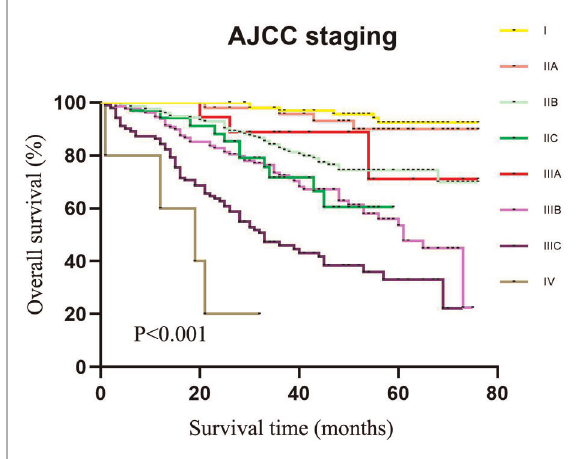
FIGURE 5 The 5-year survival rate of patients in the validation set using our cases of CRC based on the AJCC TNM staging system.